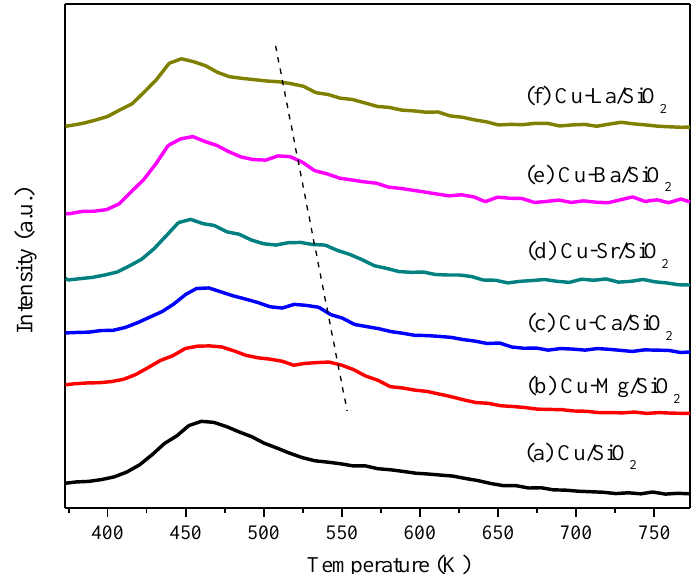
Figure 3. CO 2 -TPD profiles of the calcined catalysts: ( a ) Cu / SiO 2 ; ( b ) Cu-Mg / SiO 2 ; ( c ) Cu-Ca / SiO 2 ; ( d ) Cu-Sr / SiO 2 ; ( e ) Cu-Ba / SiO 2 ; ( f ) Cu-La / SiO 2 .